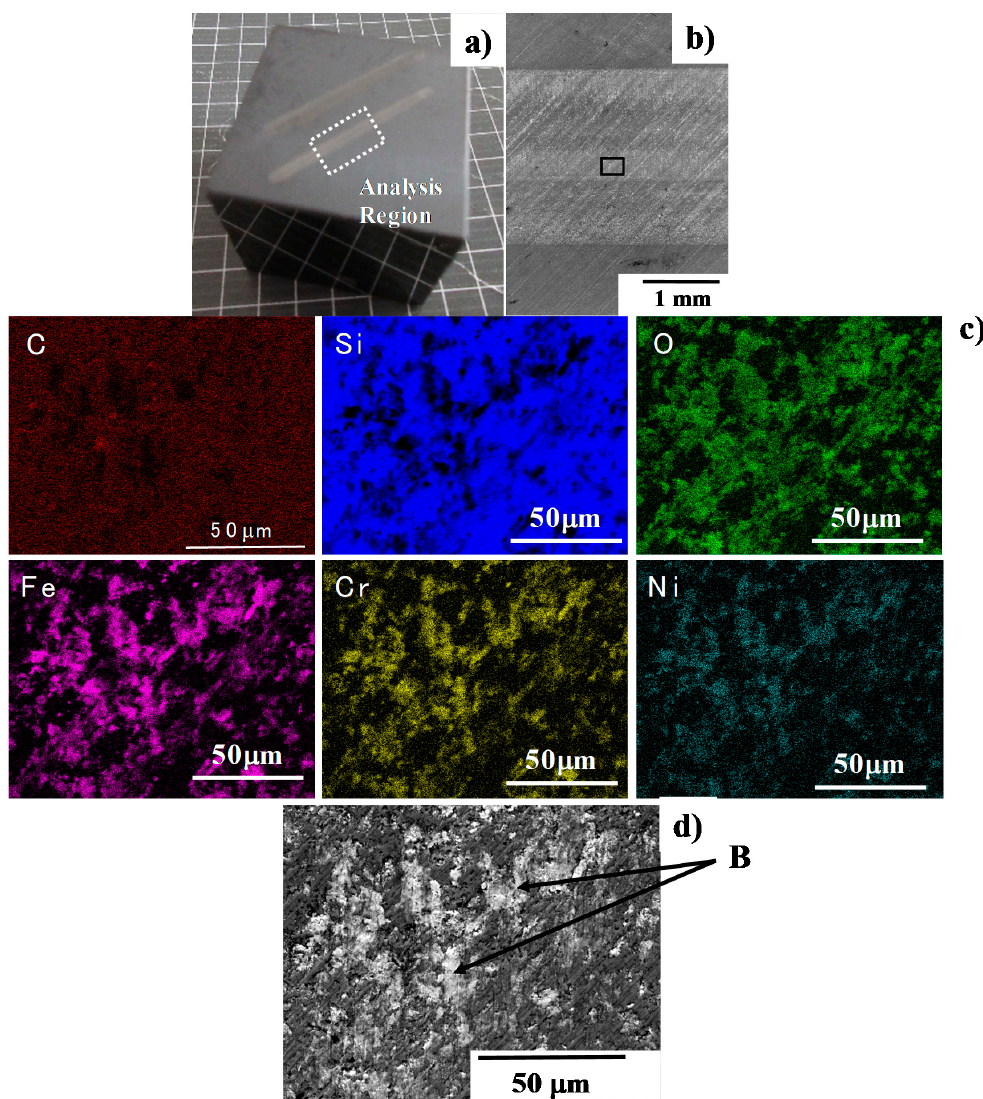
Figure 10. SEM and electron-dispersive X-ray (EDX) analyses at the vicinity of the center of the contact interface between the SiC-coated punch and the AISI316 wire after forging by 10 shots up to the reduction of diameter by 40%. ( a ) Optical microscopic image on the SiC coating punch surface; ( b ) SEM image in low magnification on the contact interface of the SiC coating; ( c ) element mapping by C, Si, O, Fe, Ni and Cr and ( d ) SEM image on the oxide fragment deposits at the center of the contact interface (pointed by “B”).